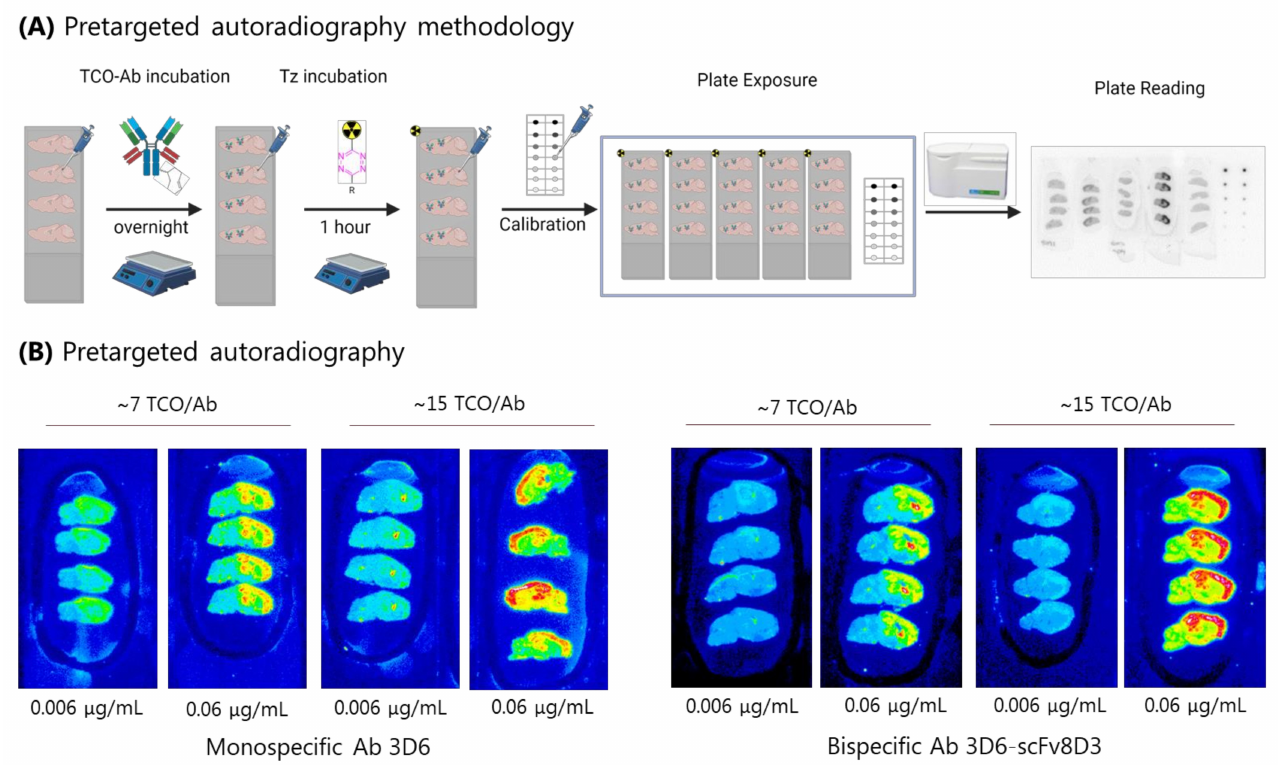
Figure 3. ( A ) The pretargeted autoradiography workflow. TCO-Abs was applied first and incubated overnight. Then, the radiolabeled Tz was applied. Slides were washed and a calibration curve was added before slide exposure to the phosphor plates. Phosphor plates were read-out to provide the autoradiography images. ( B ) Examples of the autoradiography results with TCO-3D6 and TCO- 3D5scFv8D3. Increasing TCO-loading and TCO-Ab concentration increased the imaging contrast. Similar results were observed for TCO-3D6 and